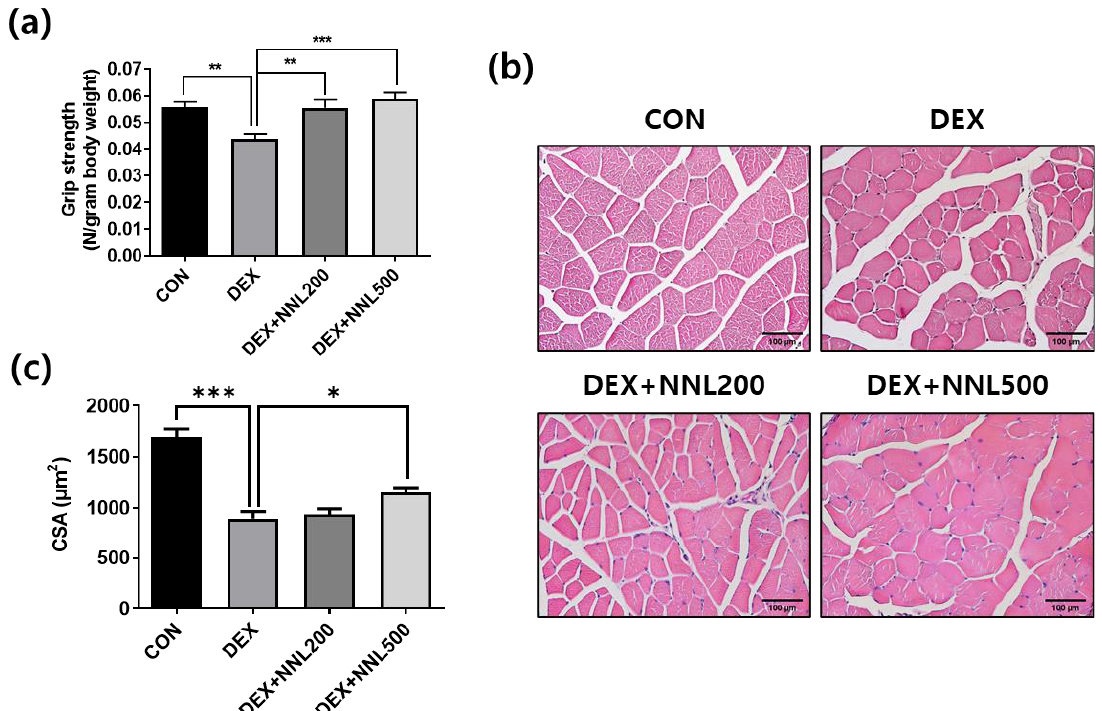
Figure 3. The NNL extract administration increased grip strength and muscle myofiber size in DEX-induced muscle atrophy in mice. ( a ) A grip strength test was performed 14 days after NNL extract administration. n = 11/group. ( b ) The QD muscle tissue sections were stained with H&E and observed under a microscope. Representative images of H&E-stained sections (original magnification, 100 × ). ( c ) Cross-sectional area (CSA) of QD muscle fiber was measured using the ImageJ program and mean CSA is shown. n = 4/group. Data are shown as mean ± S.E.M., * p < 0.05, ** p < 0.01, *** p < 0.001.